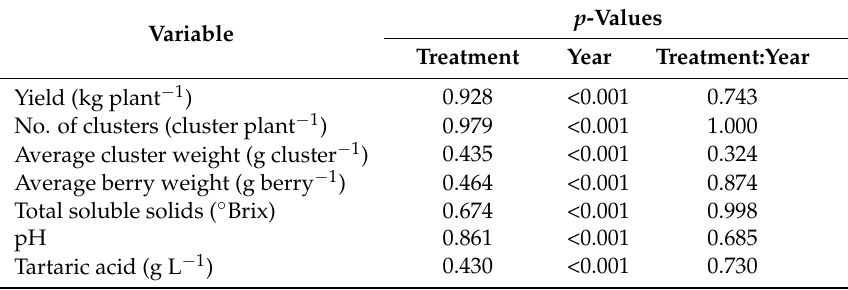
Table 4. Analysis of variance for yield, average cluster weight, average berry weight, total soluble solids, pH and tartaric acid, and analysis of deviance (type II Wald chi-square test) for the number of